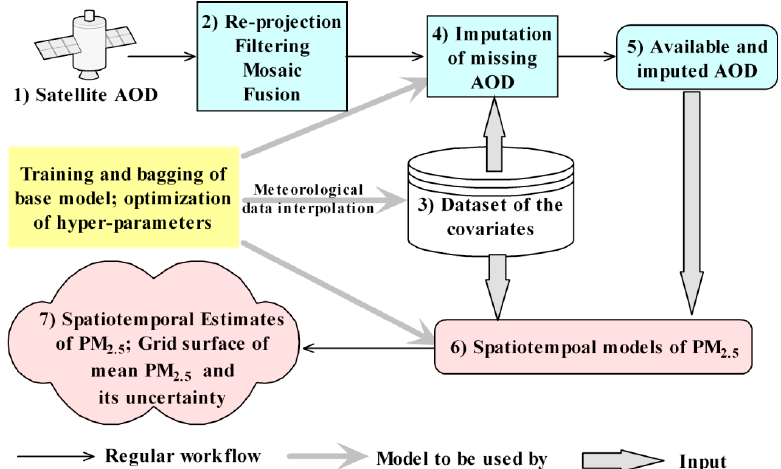
Figure 3. A workflow graph for imputation of MAIAC AOD and estimation of PM 2.5 .